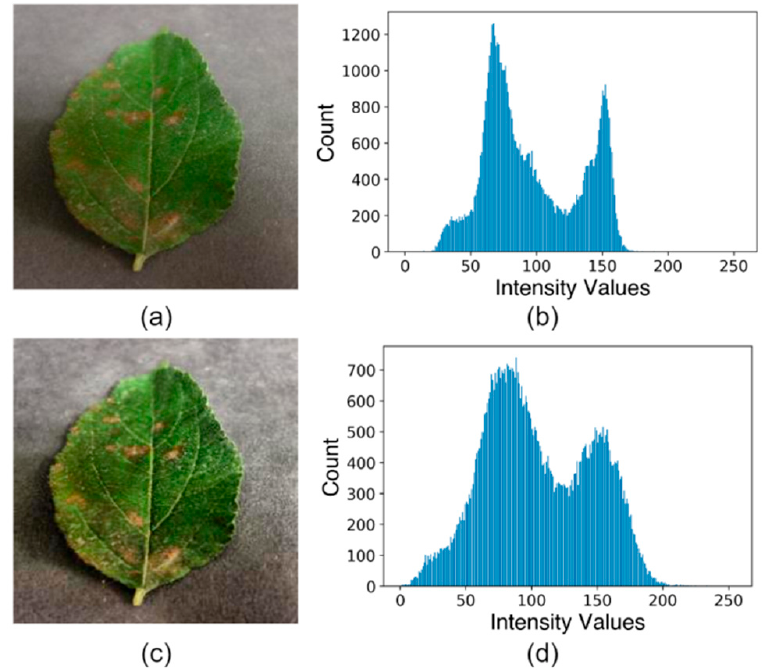
Figure 3. Comparison between the original image and the CLAHE image: ( a ) original image; ( b ) histogram of the greyscale image in ( a ); ( c ) result of enhancement using CLAHE; ( d ) histogram of the greyscale image in ( c ).